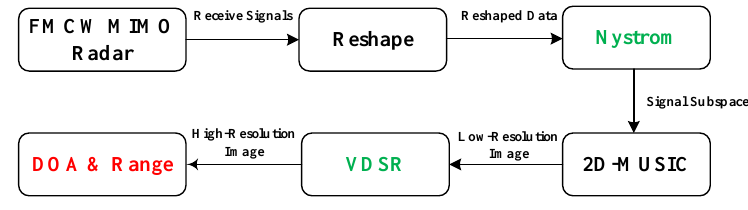
Figure 4. The structure of the proposed